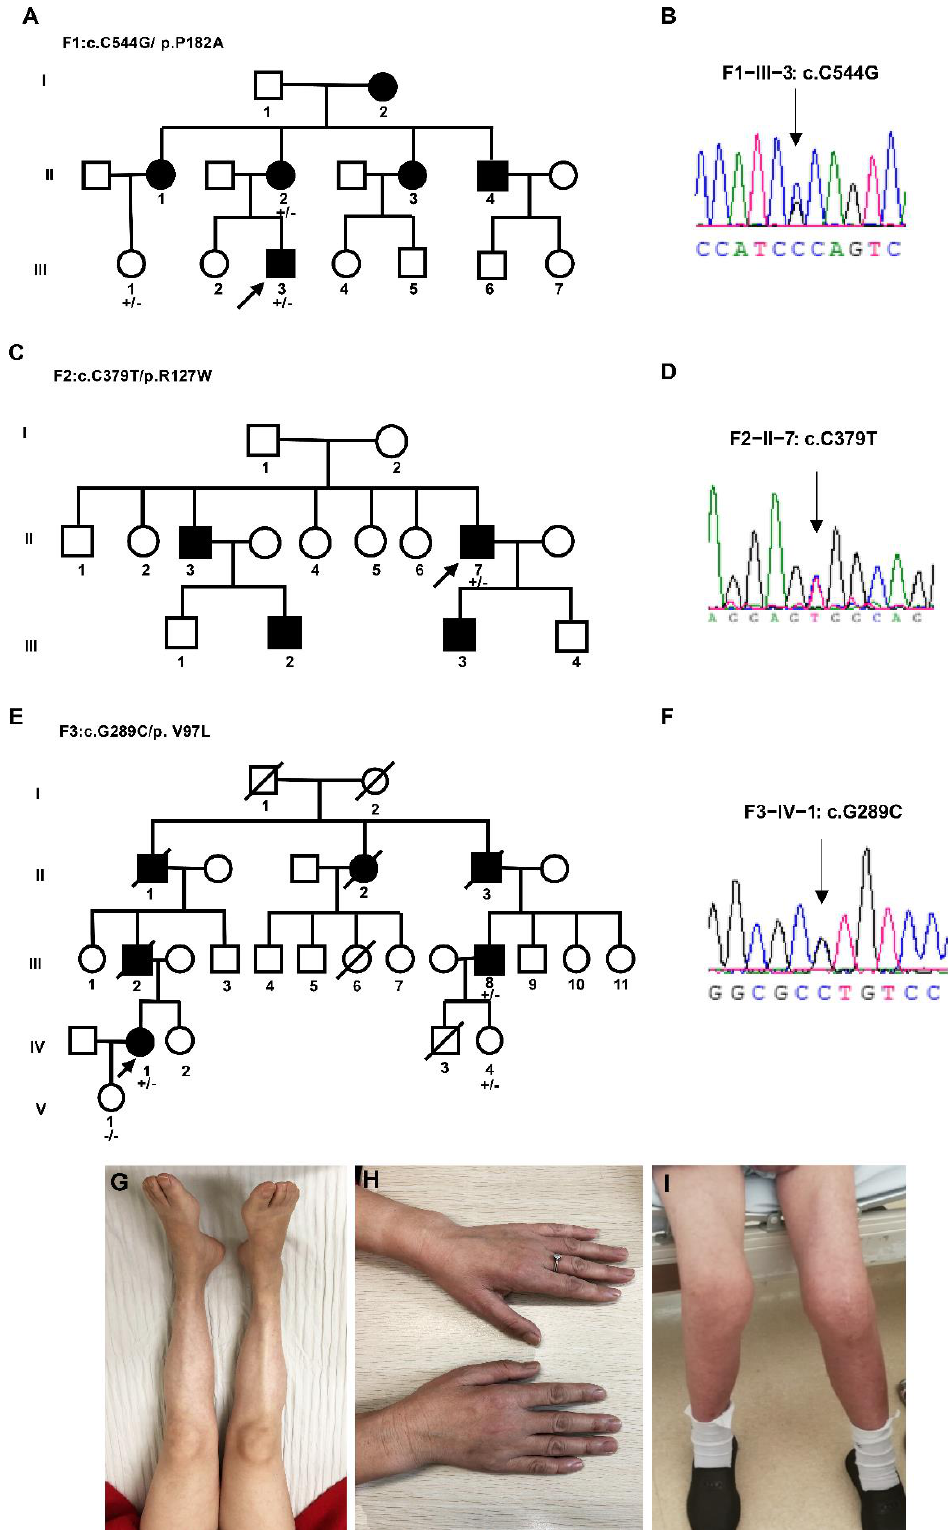
Figure 1. The family tree of three families ( A , C , E ), the Sanger sequencing verification results of probands ( B , D , F ), and clinical characterizations ( G − I ). ( G ) Tibialis anterior muscle and first dorsal interosseous muscle ( H ) atrophy of F1 − II − 2. ( I ). Bilateral proximal and distal lower limbs atrophy of proband 3. An arrow indicates the proband; square, male; circle, female; a filled symbol indicates affected; and an arrow through a symbol indicates the individual is deceased; +/ − heterozygous, − / − homozygous normal for the HSPB1 mutation.